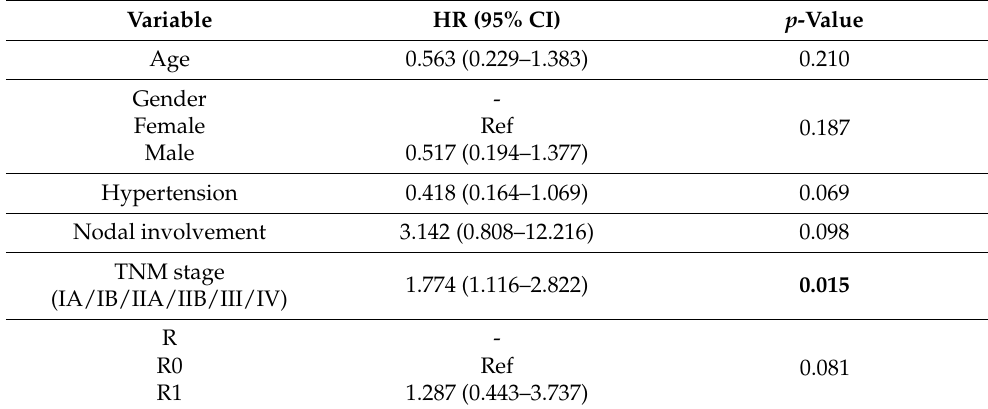
Table 4. Univariate analyses of prognostic factors for overall survival—NODM group.